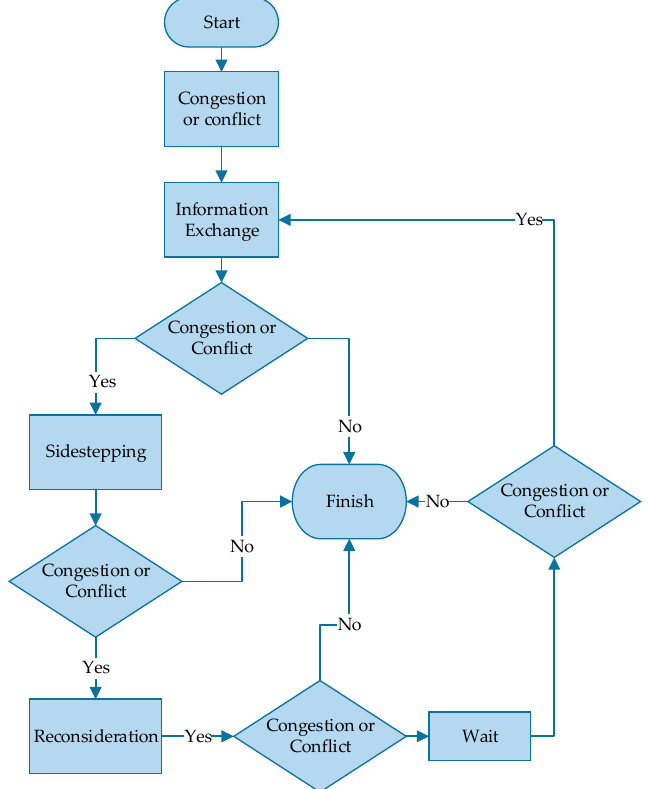
Figure 7. Flowchart for information exchange–sidestepping–reconsideration (I-S-R) behavior plan.